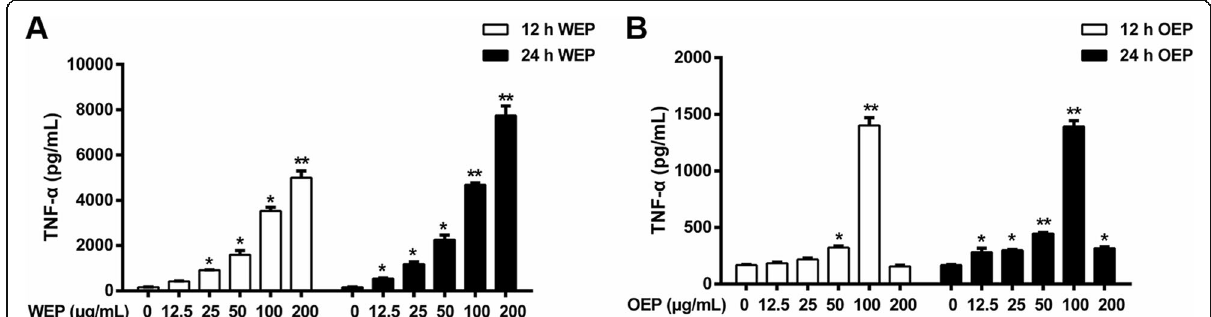
Fig. 2 TNF- α expression after exposure PM 2.5 extracts. TNF- α expression in RAW264.7 cells treated for 12 and 24h with ( a ) WEP and ( b ) OEP. * <0.05, ** <0.01 vs. control